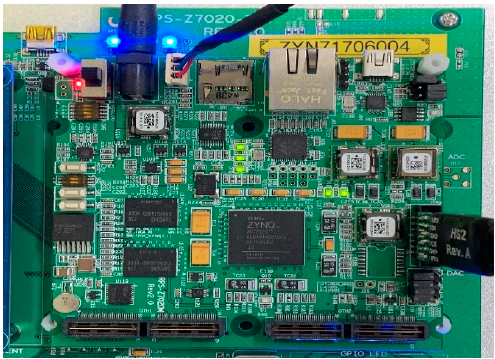
Figure 10. Zynq-7020 FPGA verification environment.